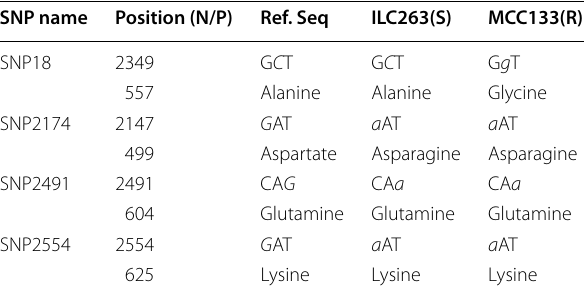
The italic letters show the position of point mutations in their associated codons